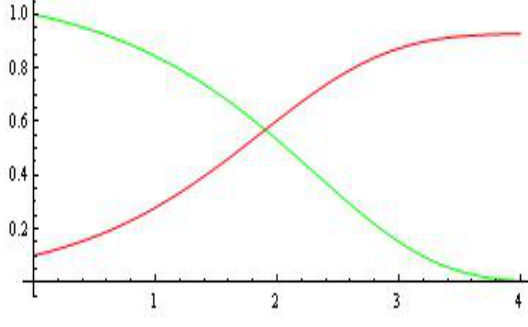
Fig. 13. The ”growth” function y ( t ) –(red) and s ( t ) –(green) for k = 1 . 1; q = 0 . 906; y 0 = 0 . 1 .